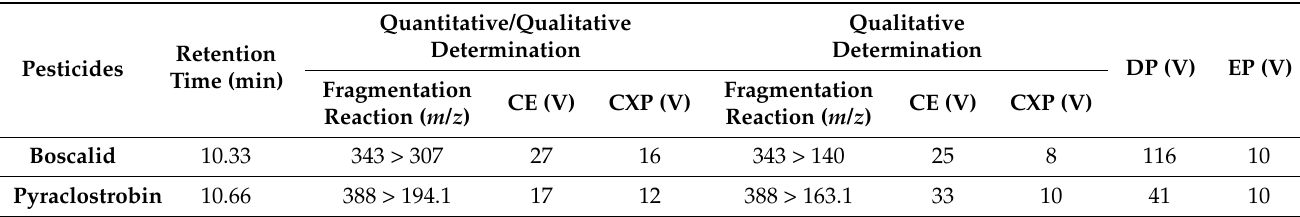
Table 4. Optimized LC-MS/MS system operating parameters for analyzed